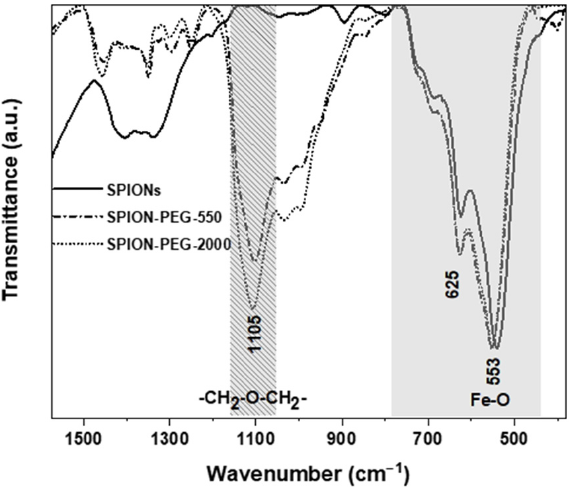
Figure 3. Fourier transform infrared (FTIR) spectra of SPIONs, SPION-PEG-550 and SPION-PEG- 2000. The characteristic C-O-C ether stretching vibration band of PEG (1105 cm − 1 ) and the bands associated with the Fe-O vibrational modes in γ -Fe 2 O 3 (625 cm − 1 and 553 cm − 1 ) are highlighted in grey stripped pattern and grey, respectively.